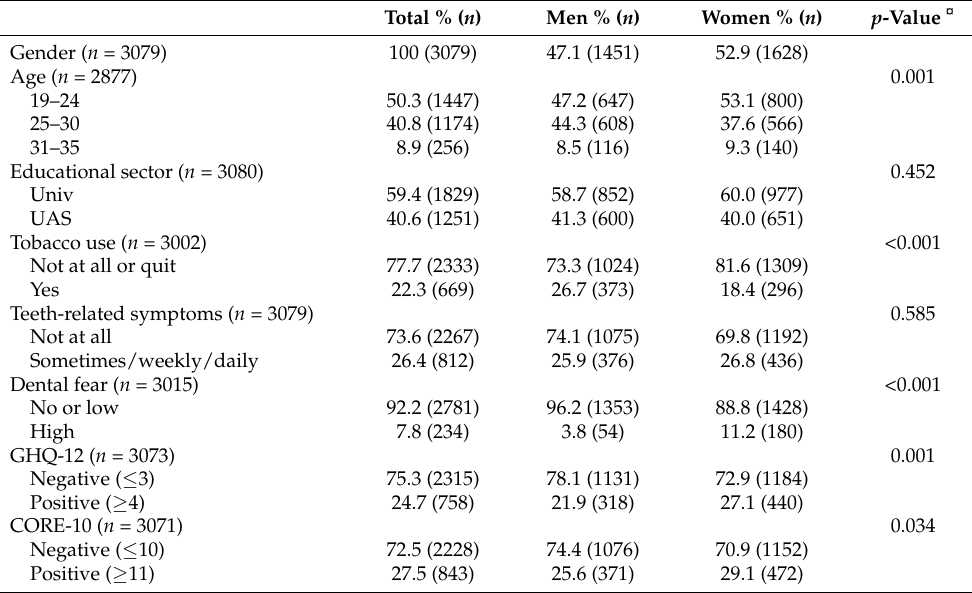
Table 1. Age groups, educational sector, dental fear, GHQ-12, CORE-10, perceived teeth-related symptoms and tobacco use of the study population by gender ( n =